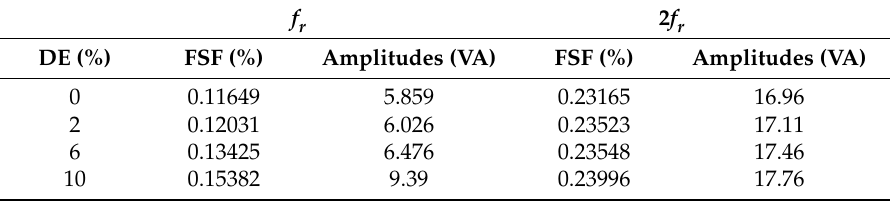
Table 1. FSFs and the amplitudes of the induction motor under four levels of